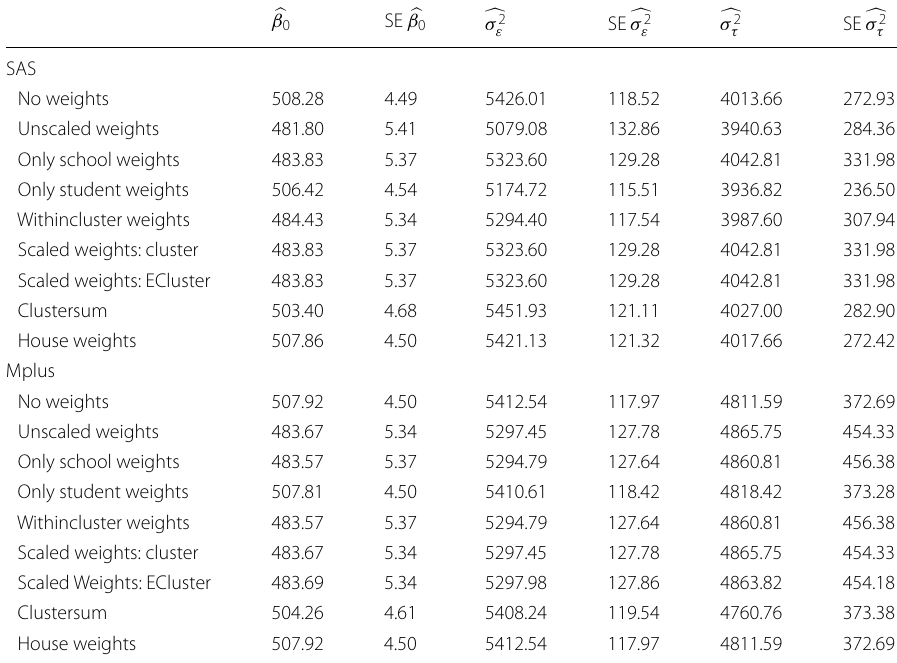
Classifying the results of the simulation study to application data, the different weighting approaches combined with different estimation algorithms implemented in the two examined software packages are displayed